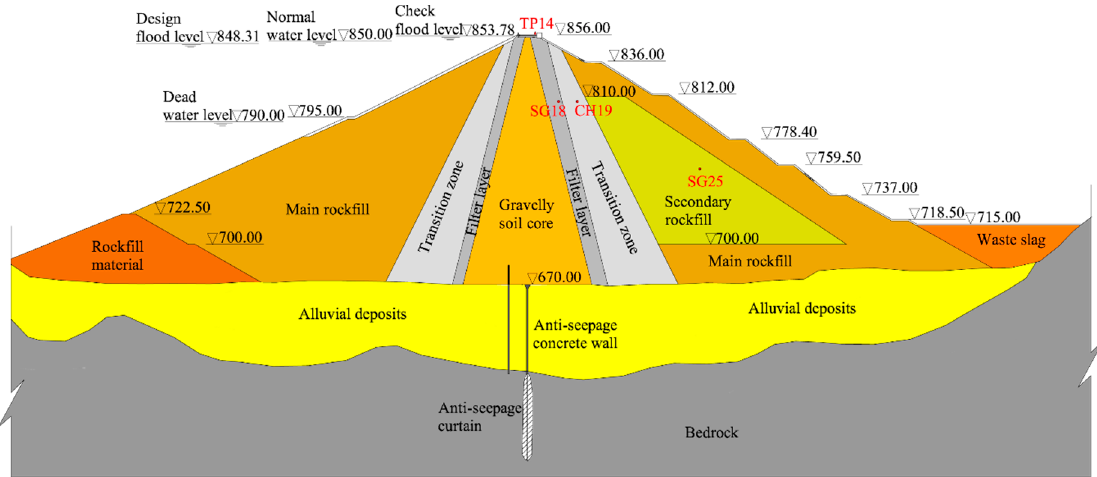
Figure 1. The highest cross section of the dam and foundation, where the red spots represent the monitoring points for calibration of the constitutive model parameters.